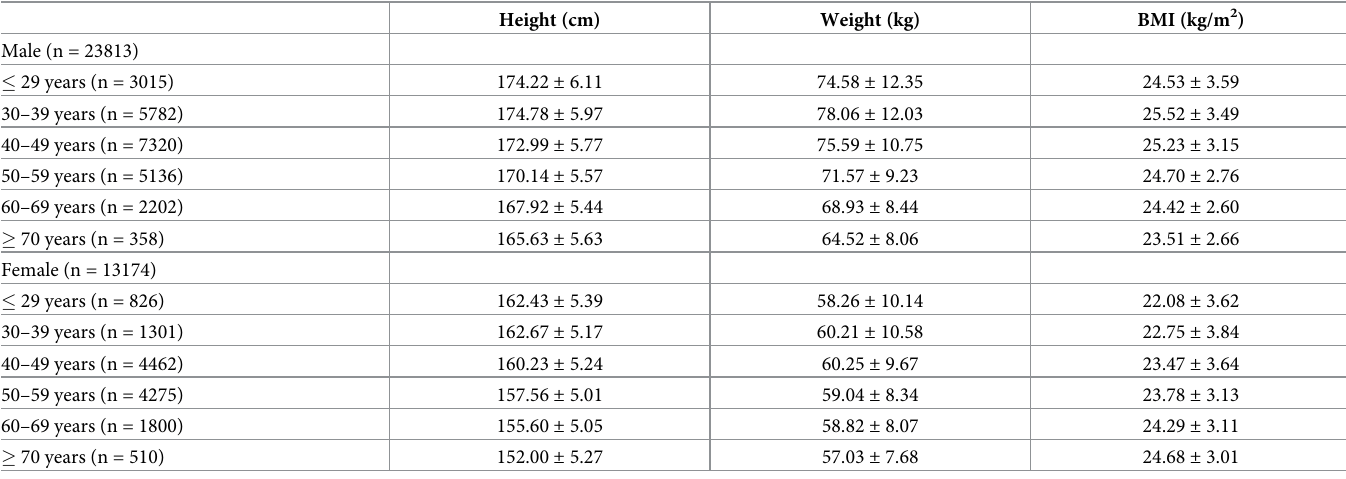
Table 1. The characteristic of the